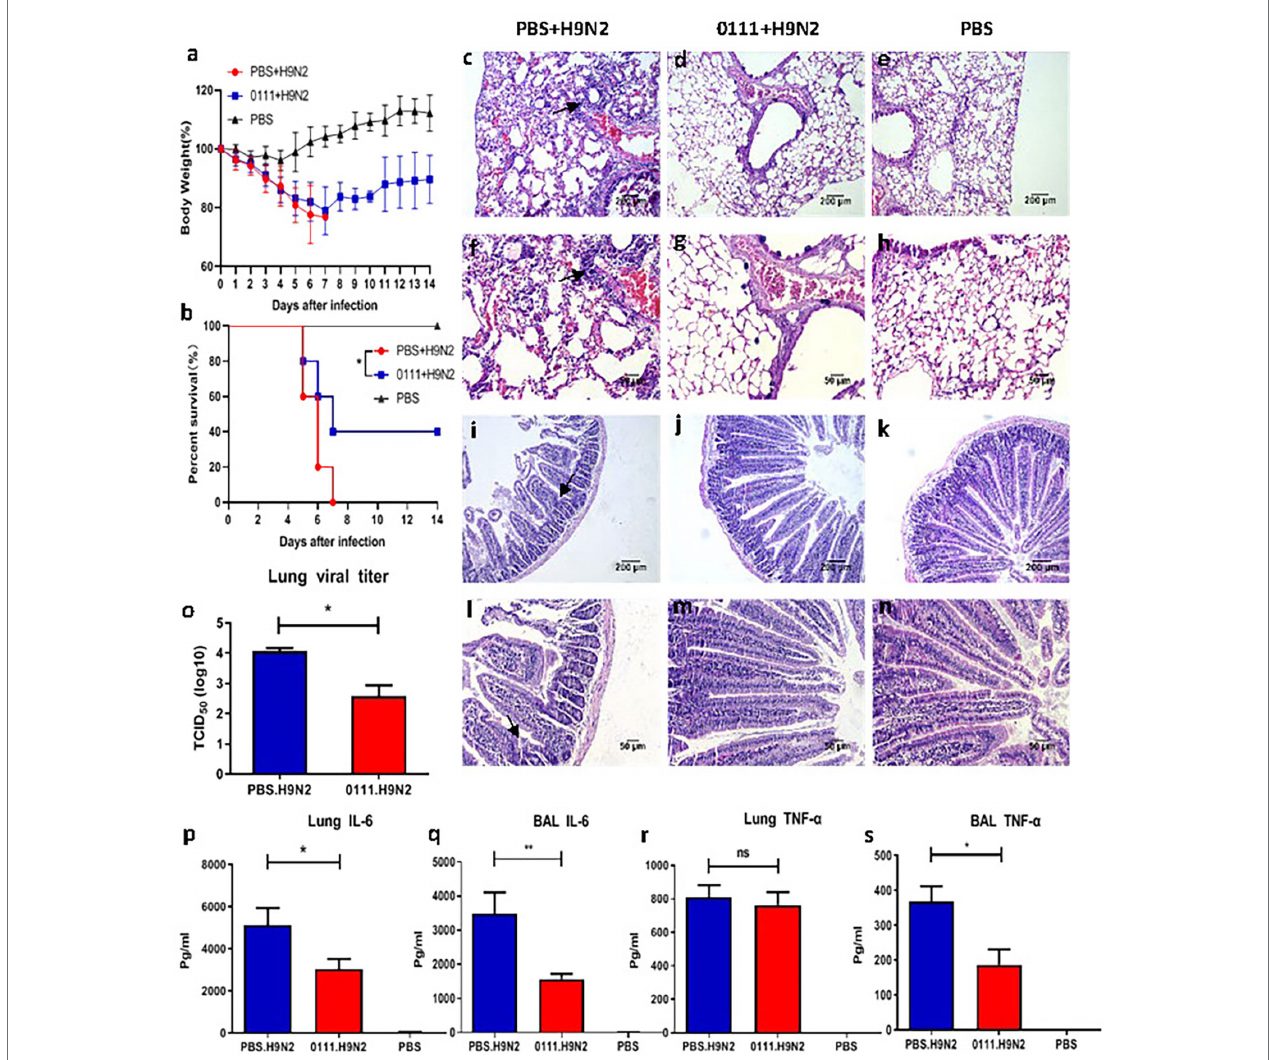
FIGURE 1 | Pretreatment of C57BL/6 mice with Lactiplantibacillus plantarum 0111 reduced weight loss, improved survival and reduced lung and jejunum tissue damage as well as reduced lung viral load and inflammatory cytokines caused by H9N2 influenza virus infection. C57BL/6 mice ( n = 5/group) were infected 7 days after the continuous oral administration of H9N2 virus (2 x LD50) by L. plantarum 0111 (1 × 108 CFU/200 glimouse). The body weight (A) and survival rate (B) of the mice are recorded within 14 days after infection. On day 5 after infection, some mice were euthanized, and the lungs and jejunum were collected and histologically analyzed. Lung viruses and inflammatory cytokines were measured in the lungs and bronchoalveolar lavage fluid (BALF). (C,D,E,I,J,K) magnification at 100×. The scale bar indicates 200 μ m. (F,G,H,L,M,N) magnification at 200×. The scale bar indicates 50 μ m. (C,F) the lungs of mice were challenged with H9N2 after PBS pretreatment; (D,G) the lungs of mice were challenged with H9N2 after L. plantarum 0111 pretreatment; (E,H) the lungs of mice were challenged with PBS only. (I,L) mouse jejunum challenged with H9N2 after PBS pretreatment; (J,M) mouse jejunum challenged with H9N2 after L. plantarum 0111 pretreatment; (K,N) mouse jejunum treated with PBS only. (O) pulmonary virus log 10 TCID 50/g lung tissue. (P) IL-6 (pg/ml) in lungs. (R) TNF- α (pg/ml) in lungs. (Q) IL-6 (pg/ml) in BALF. (S) TNF- α (pg/ml) in BALF. The results are presented as the means ± SEMs ( N = 5), and statistical significance was calculated by one-way ANOVA. * P < 0.05; ** P <